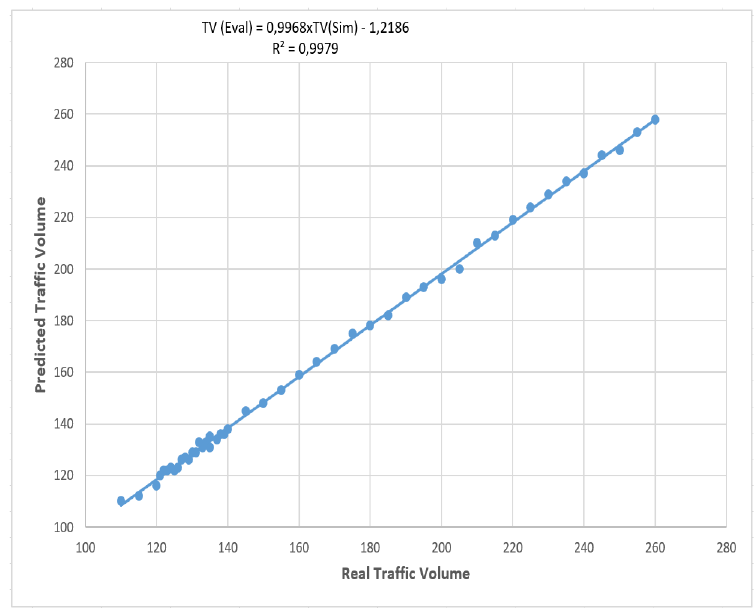
Figure 8. Predicted traffic flow vs real traffic